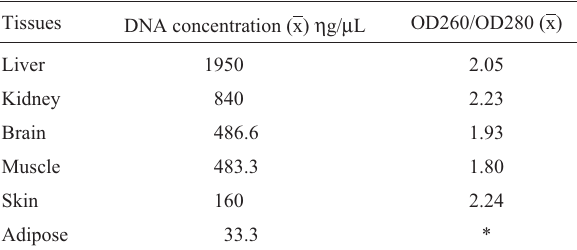
Table I - DNA concentration and OD ratio (A260/A280) of DNA extracted from different tissues.